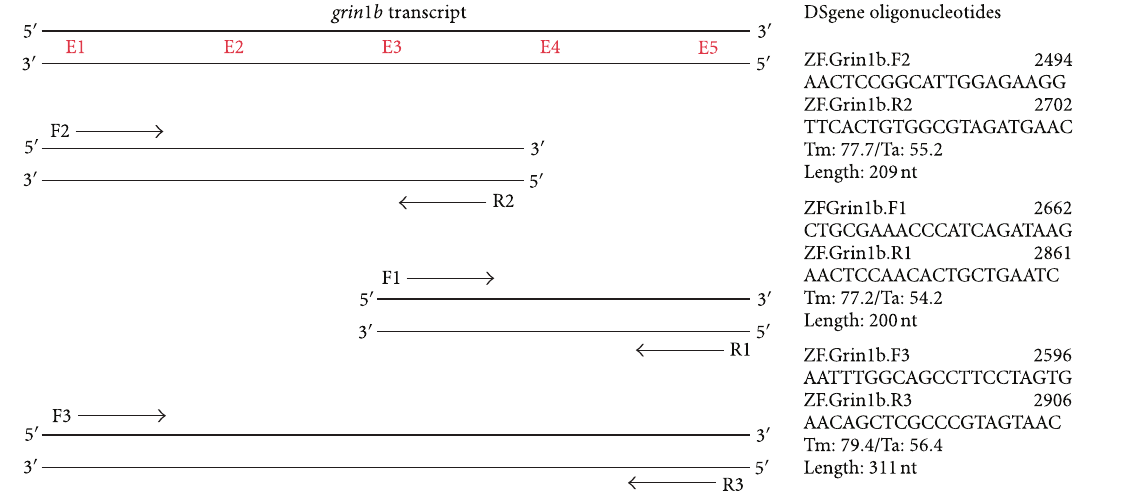
Figure 2: Editing locations. Using the DS Gene computer program (Accelrys), primer pairs were designed to amplify the grin1b transcript regions containing the predictive editing events. A total of three primer pairs were constructed, two of which (F1/R1 and F2/R2) amplified a region containing at least three of the five possible edits, and one primer pair (F3/R3) targeted to amplify a region containing all five possible edits.